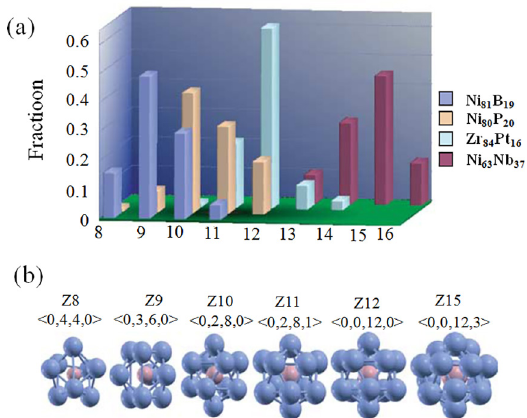
Figure 7. (a) The coordination number distribution of solute atoms in several metallic glasses; (b) The corresponding polyhedron structure. 103